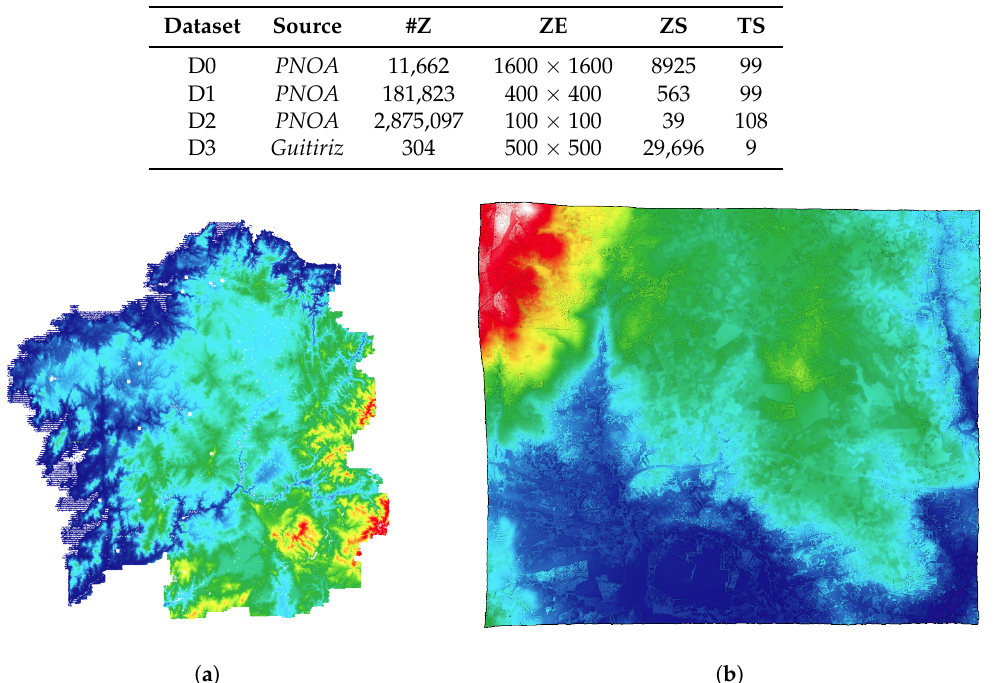
Figure 5. Point clouds used for the analysis: ( a ) rendering of the PNOA point cloud, specifically the region of Galicia (Spain); and ( b ) rendering of the Guitiriz point cloud, with a village and its surroundings